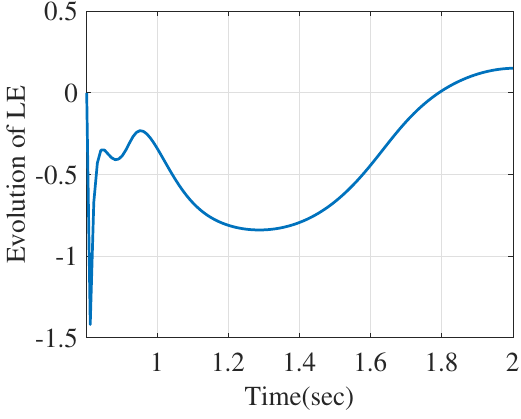
Figure 4. System LE evolution in case ( a ) with N =